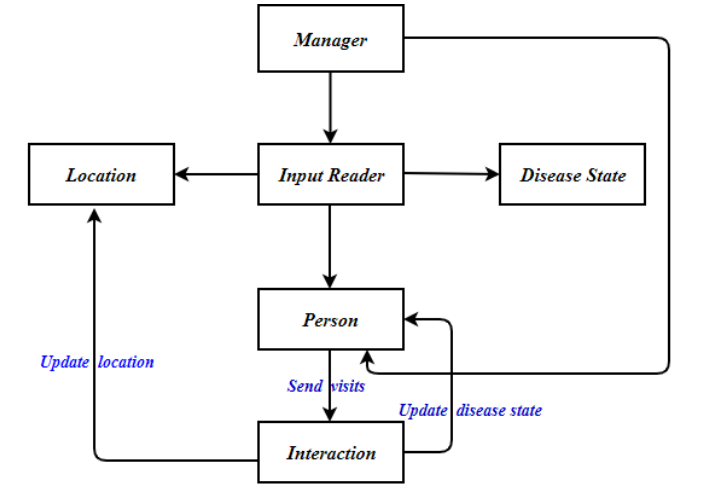
Figure 4. The SIM-D simulator flowchart. The Manager reads population network files and assigns population network to Persons, and disease parameters to Disease State. The Persons interact with other persons and update its status when interaction has outcome. The persons also update locations when outcome is calculated.